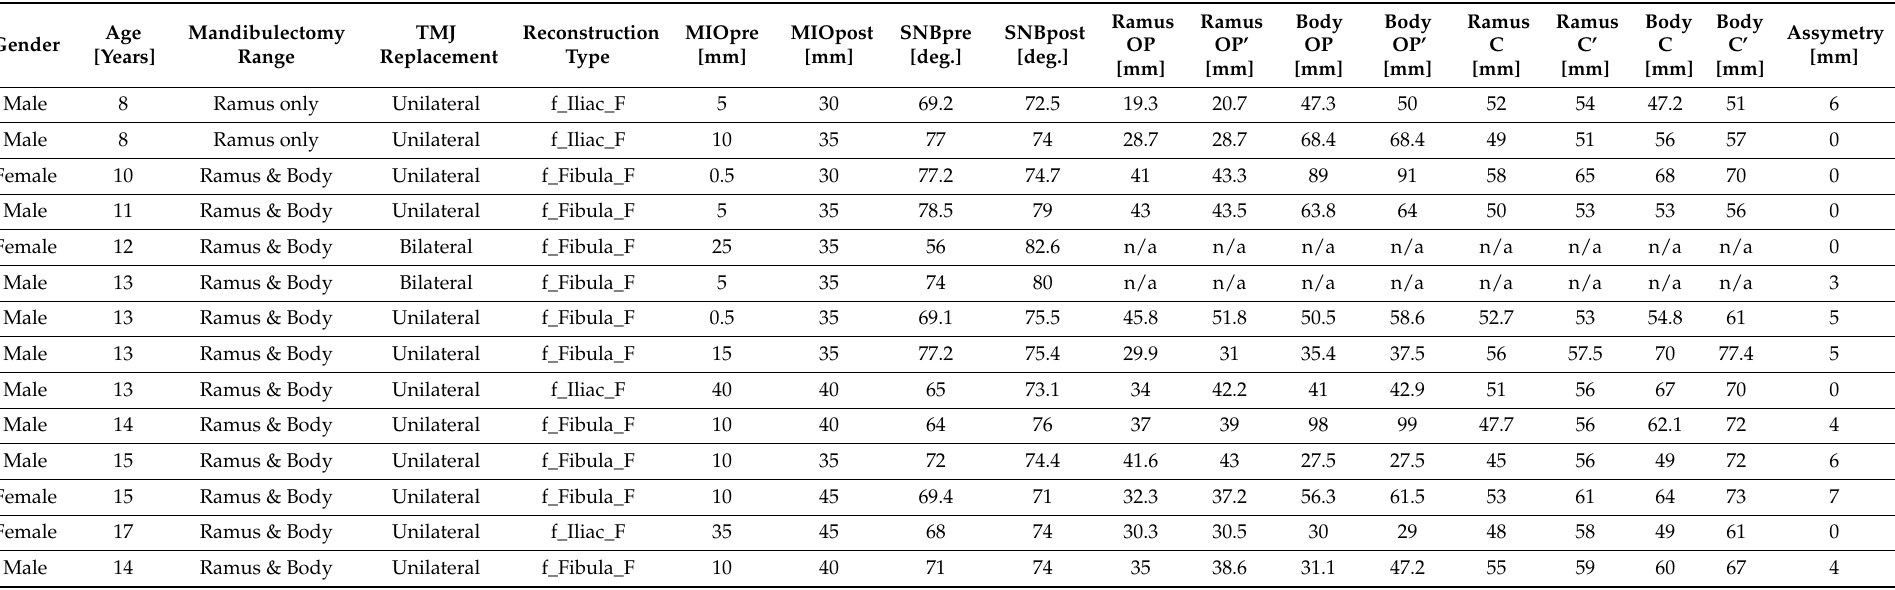
Table 2. Measurements of mandible growth on the day of surgery and during the follow-up (2–6 years postoperative), where MIOpre is maximal interincisal opening before resection and reconstruction; MIOpost is maximal interincisal at the final follow-up; Ramus OP is the height of the operated ramus before surgery; Ramus OP’ is the height of the operated ramus after surgery; Body OP is the length of the operated body before surgery; Body OP’ is the length of the operated body after surgery; Ramus C is the height of the nonoperated ramus before surgery; Ramus C’ is the height of the nonoperated ramus after surgery; Body C is the length of the nonoperated body before surgery; and Body C’ is the length of the nonoperated body after surgery. Bilateral N/A: as the procedure was done bilaterally in two patients there was no reference point for estimating the operated vs. nonoperated side for statistical